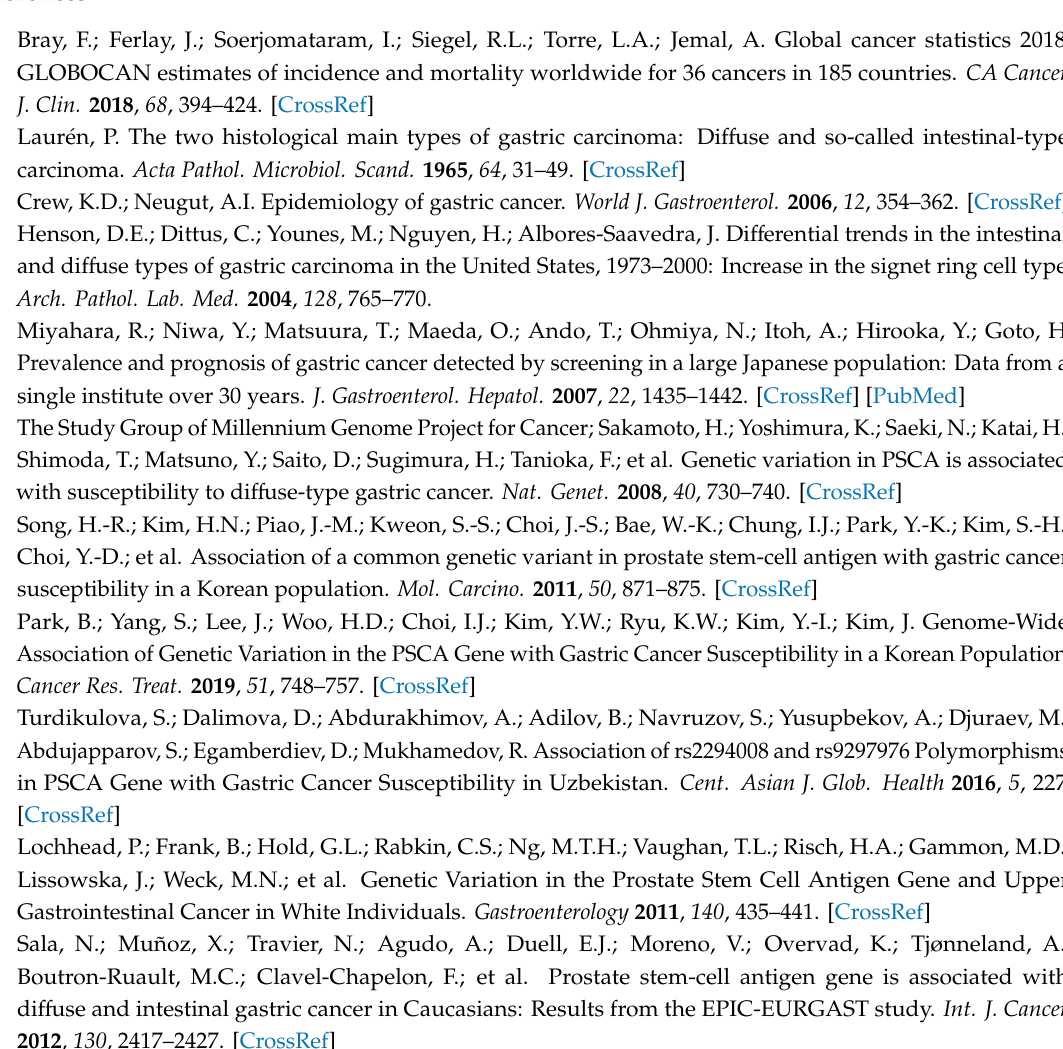
LD block; Table S6: Nucleotide diversity at LD block and flanking 100 kb regions; Table S7: Genes and transcript consequences of rs2976391; Table S8: Motif feature consequences of